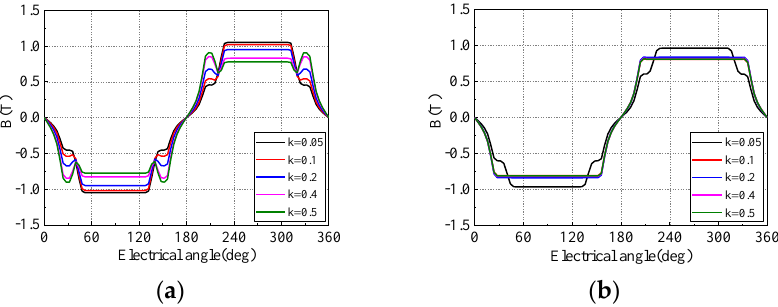
Figure 4. The air gap flux density waveforms and corresponding fundamental amplitudes and total harmonic distortions (THDs) of ST AFIPM machines: ( a ) air gap flux density waveforms; ( b ) fundamental amplitude and THD comparison.